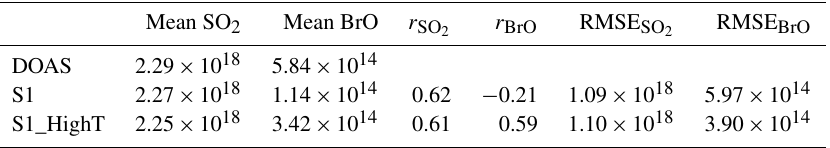
Table 5. Statistical comparison between the DOAS SO 2 and BrO columns from the five traverses of the Ambrym plume on 12 January 2005 and the corresponding simulated values (for S1 and S1_HighT). Correlation coefficients ( r ), root mean square error (RMSE in molecule cm − 2 ) are given as well as mean values (molecule cm − 2 ) of observed and simulated data. Note that we did not include the data here for which we did not have GPS data (dashed lines of Figs. 3 and 4). r BrO RMSE SO Mean SO 2 Mean BrO r SO 2